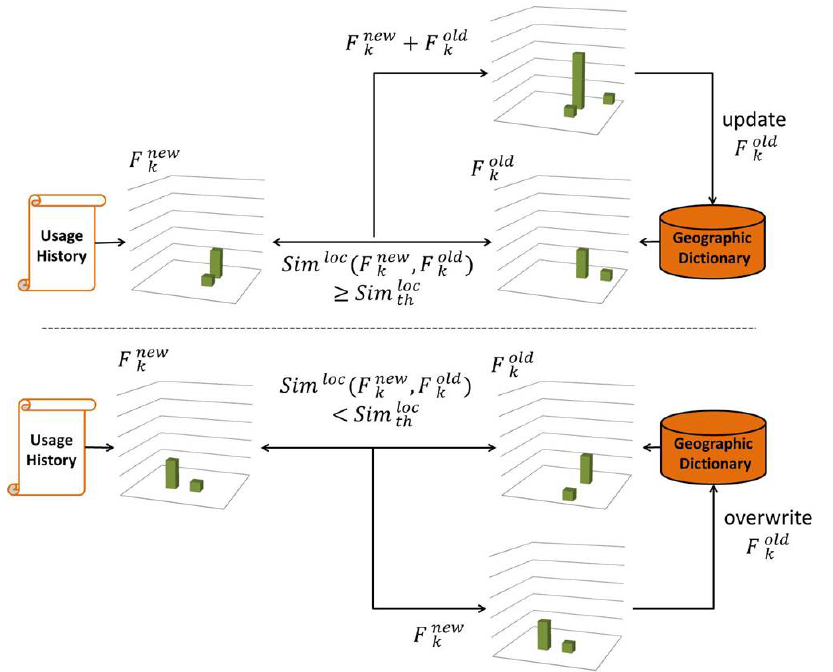
Figure 5. When the local word l k in the geographic dictionary is determined as a local word again, its past area-based frequency histogram F old recorded in the geographic dictionary is updated according k to the similarity to F new , which is its area-based frequency histogram in the current usage k